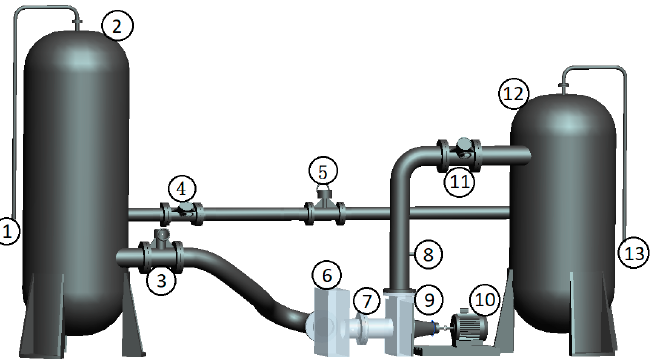
Figure 6. Schematic diagram of closed test platform. 1. Vacuum pump; 2. Cavitation tank; 3, 4, 11. Valve; 5. Electromagnetic Flowmeter; 6. Transparent water tank; 7, 8. Pressure transducer; 9. Test pump; 10. Motor; 12. Voltage-stabilizing tank; 13. Exhaust port.